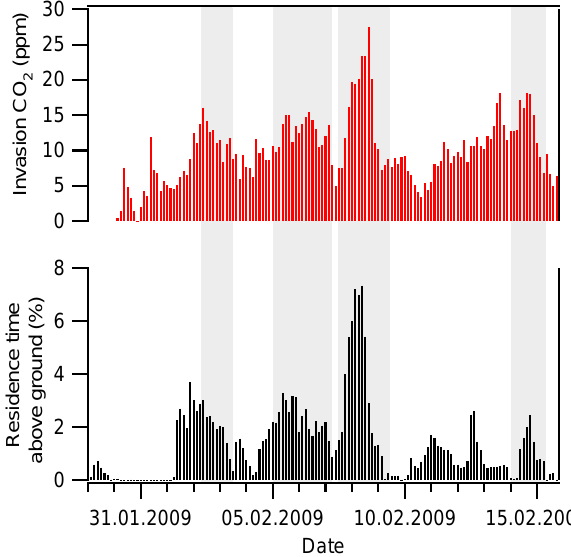
Fig. 8. Top panel indicates the amount of atmospheric CO 2 which exchanged its oxygen isotope with soil water (for details see text). Bottom panel shows the total residence time of the air-masses in a layer up to 100m above ground relative to total residence time (5-days) as calculated from the LPDM at 4 h time intervals.